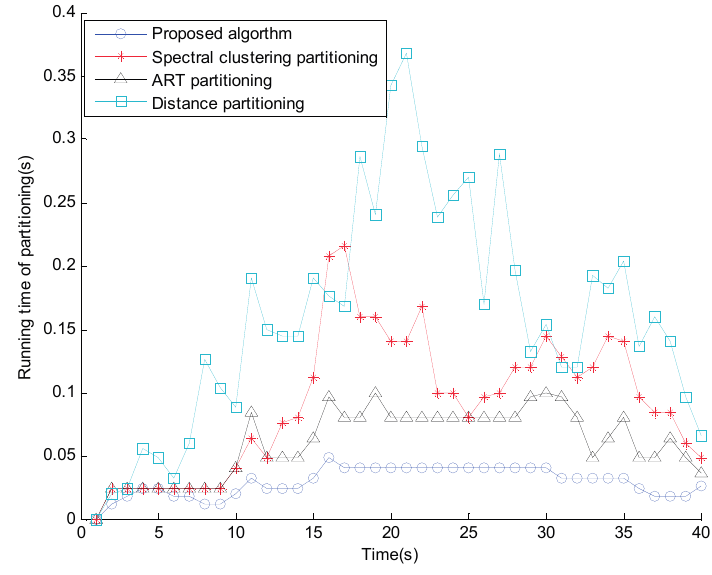
Figure 7. Running time of